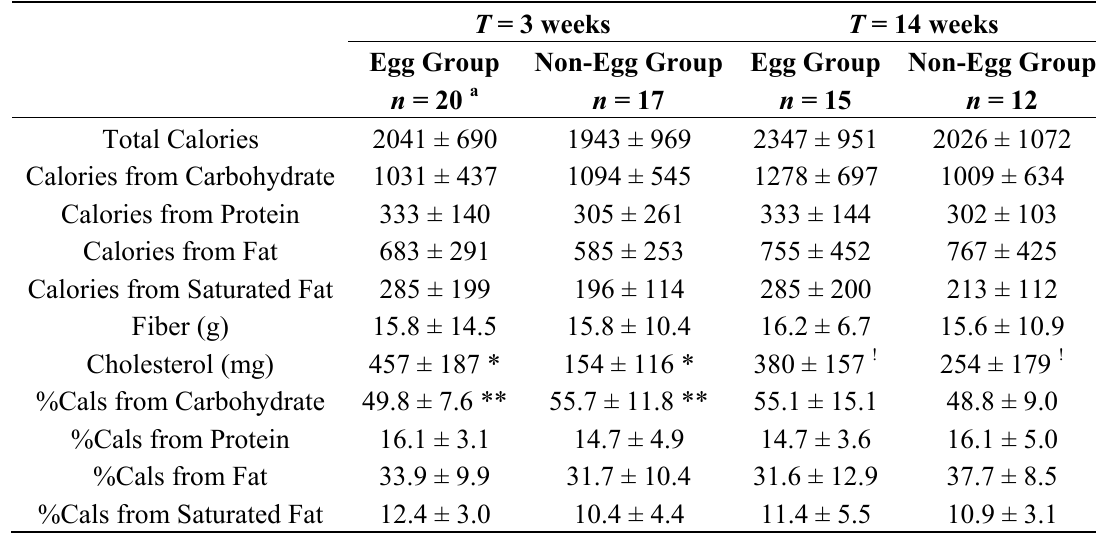
Table 4. Average Nutrient Intake (per day) based on 3 day-food